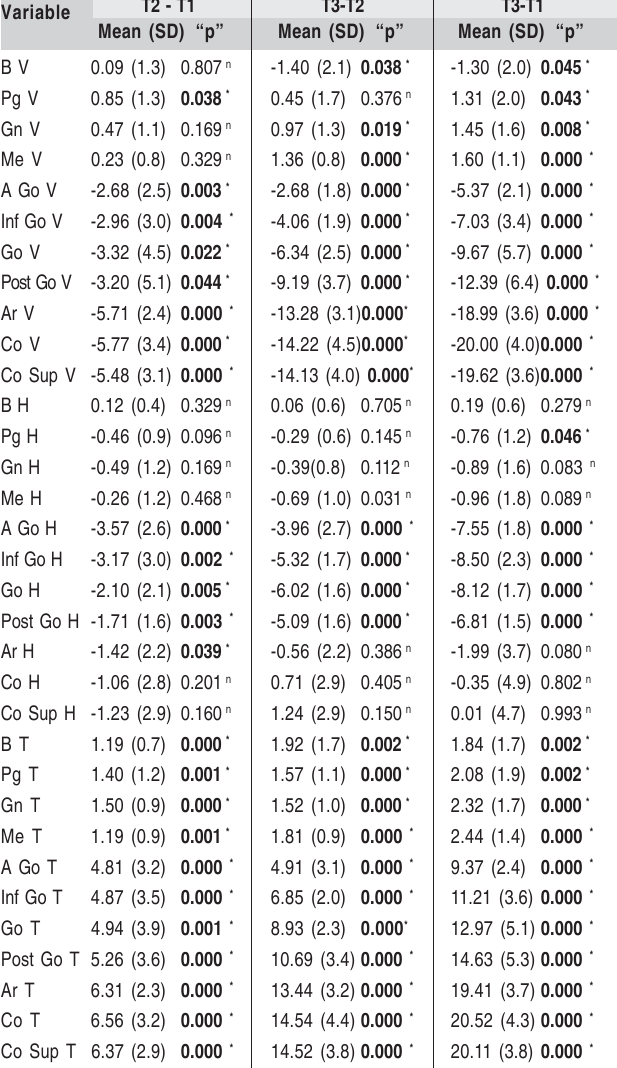
Table 5 - Mandibular growth (vertical, horizontal and total) and remodeling (in